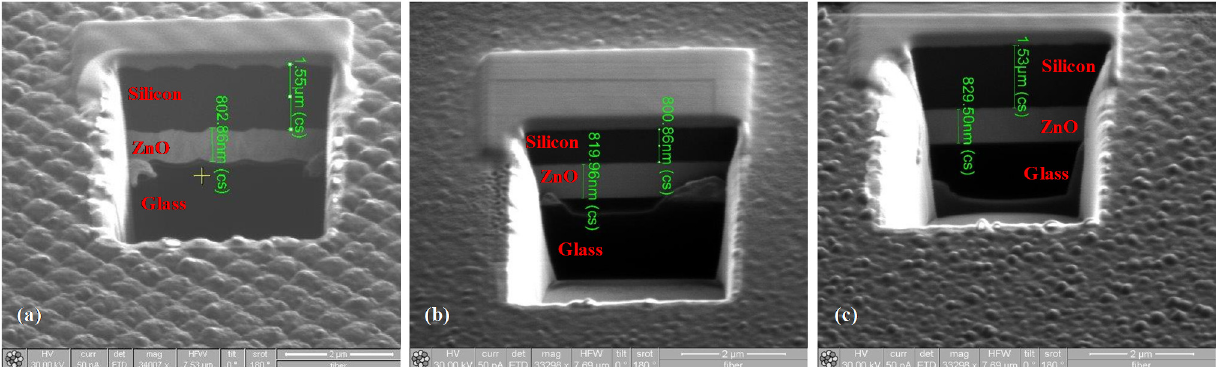
Figure 5. Cross-section of the fabricated solar cells for the textured cell ( a ) and for the cell fabricated on flat substrates with silicon thicknesses of 800 nm ( b ) and 1500 nm ( c ). From the measurements, the thicknesses for the ZnO layer are approximately 820 nm and 830 nm, and those for the silicon layer are 800 nm and 1530 nm for the cell with a nominal silicon layer thickness of 800 nm and 1500 nm, respectively.